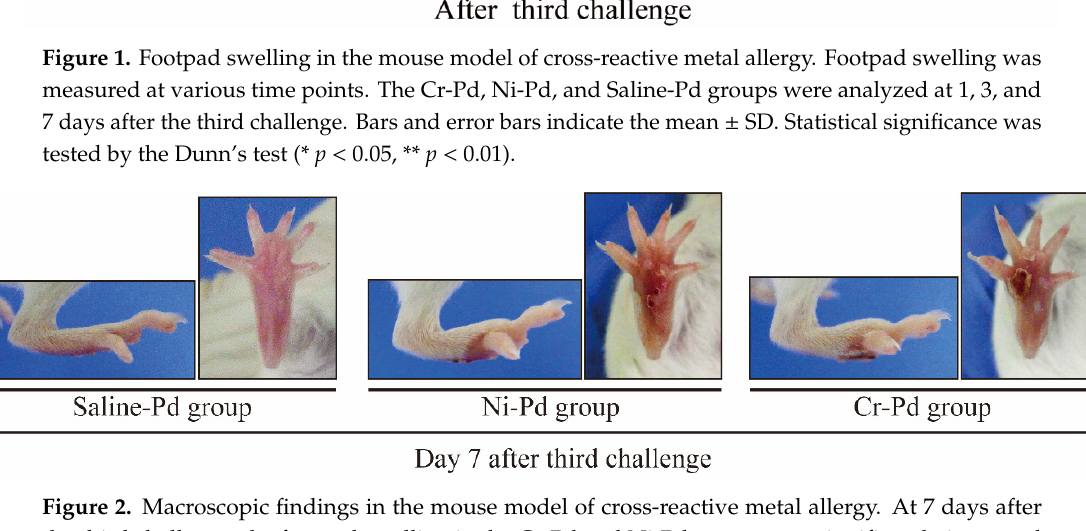
Figure 2. Macroscopic findings in the mouse model of cross-reactive metal allergy. At 7 days after the third challenge, the footpad swelling in the Cr-Pd and Ni-Pd groups was significantly increased compared with Saline-Pd group. Swelling and crust formation of the footpad were observed at 7 days after the third challenge in the Ni-Pd and Cr-Pd groups.